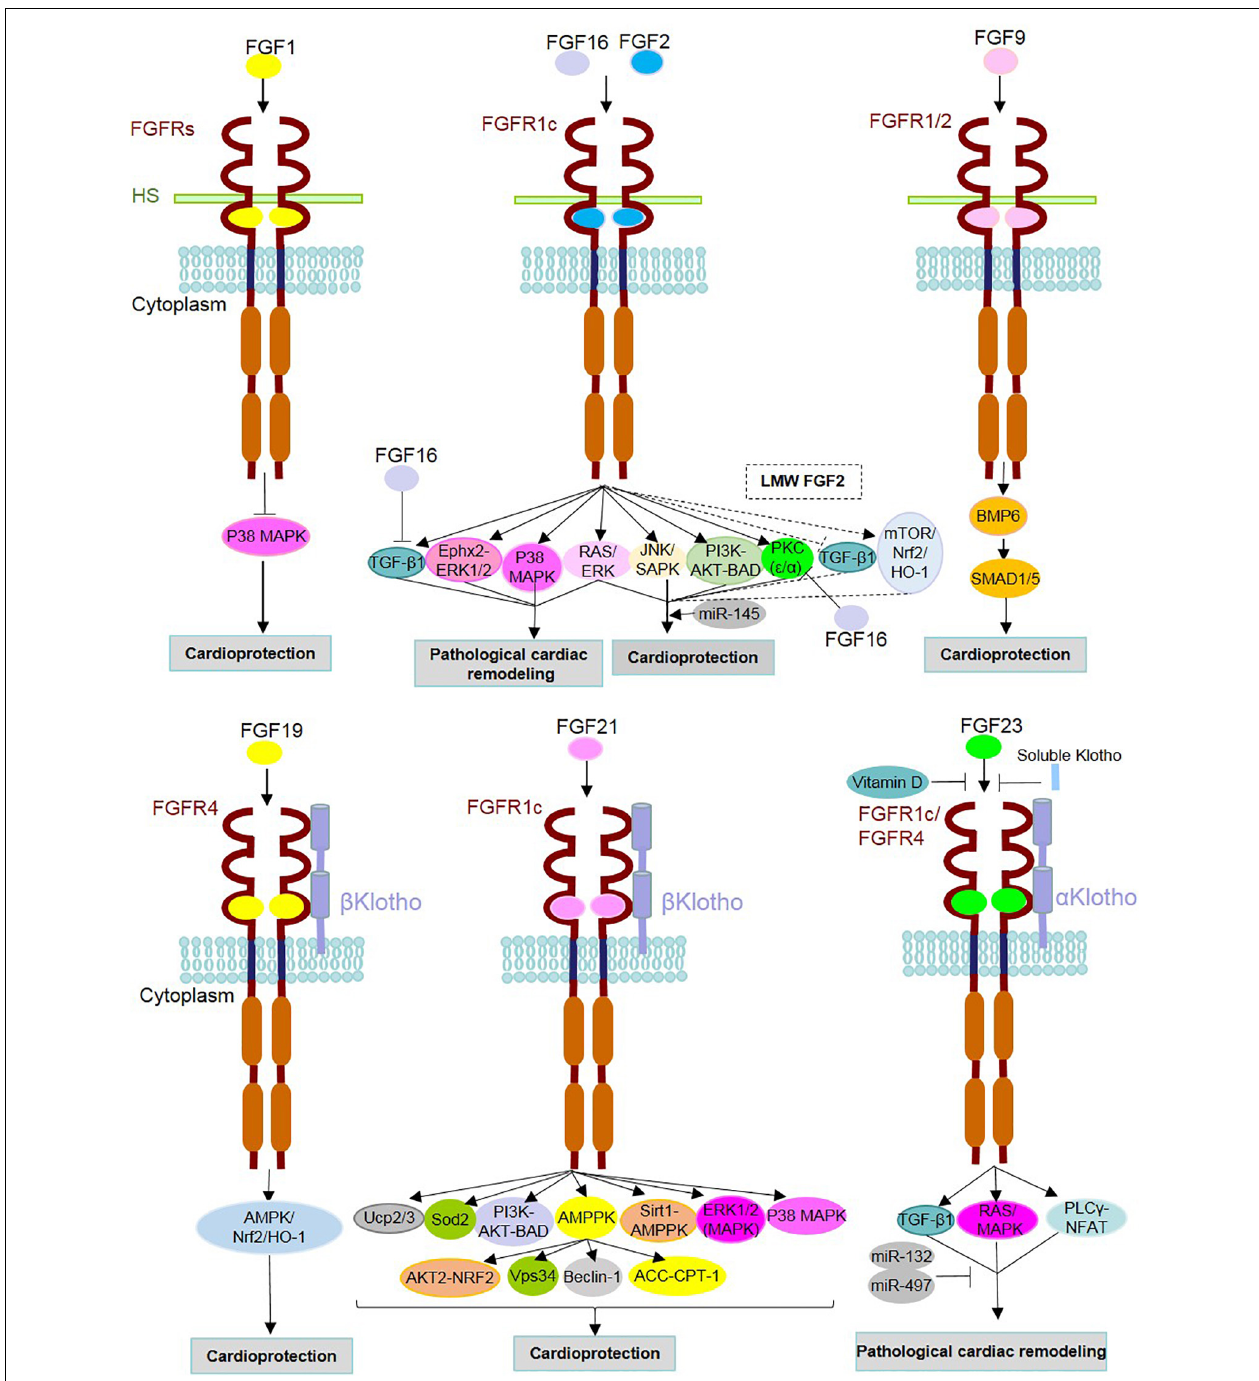
FIGURE 2 | Mechanism of action of FGFs and identified underlying signaling contributors in heart homeostasis, repair and diseases. FGF ligands (FGFs) are involved either in the protection or pathogenesis of the heart through binding with FGF receptors (FGFRs) and cofactors [i.e., heparan sulfate (HS) and α / β Klothos]. After dimerization, they contribute to the activation/inhibition of underlying intracellular signaling pathways. FGF16 and FGF2 can target the same receptor (FGFR1c), but with opposite functions. As an antagonist of FGF2, FGF16 inhibits TGF β 1 and PKC isoforms (PKC- α and PKC- ε ). FGF2 is known to play both adaptive and maladaptive roles in cardiac events, and this could be due to the distinct effects of its isoforms [low- and high-molecular-weight isoforms (LMW and HMW)]. Dashed lines indicate signaling pathways and effects related to LMW FGF2. Vitamin D and soluble Klotho suppress the detrimental effects of FGF23-FGFR interactions. MicroRNAs (miR) mediate cardioprotective functions such as miR-145 in association with the Ras-MAPK and PI3K-AKT-related effects of FGF2 as well as miRs-132 and miR-497 through inhibition of FGF23-involved adverse cardiac events.